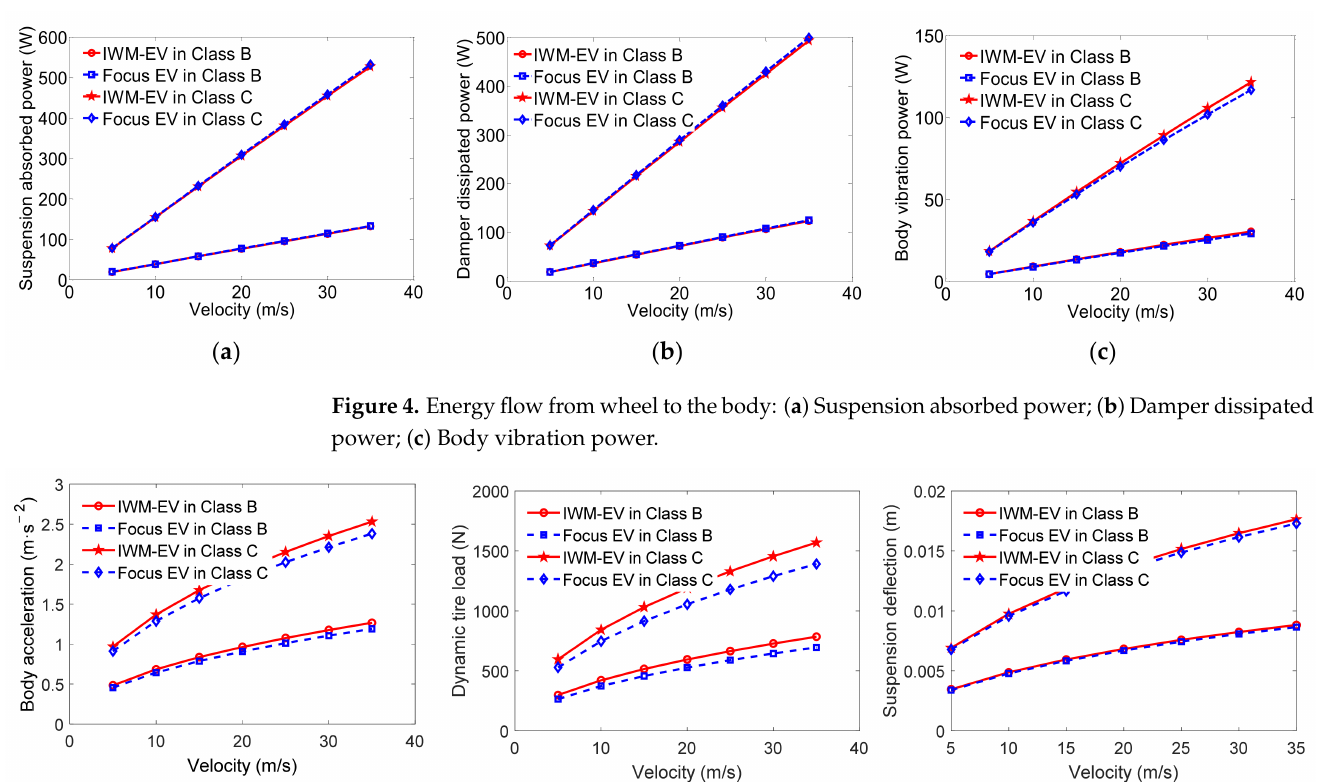
Figure 3. Energy flow from road to wheel: ( a ) Tire absorbed power; ( b ) Tire damping dissipated power; ( c ) Wheel vibration power.